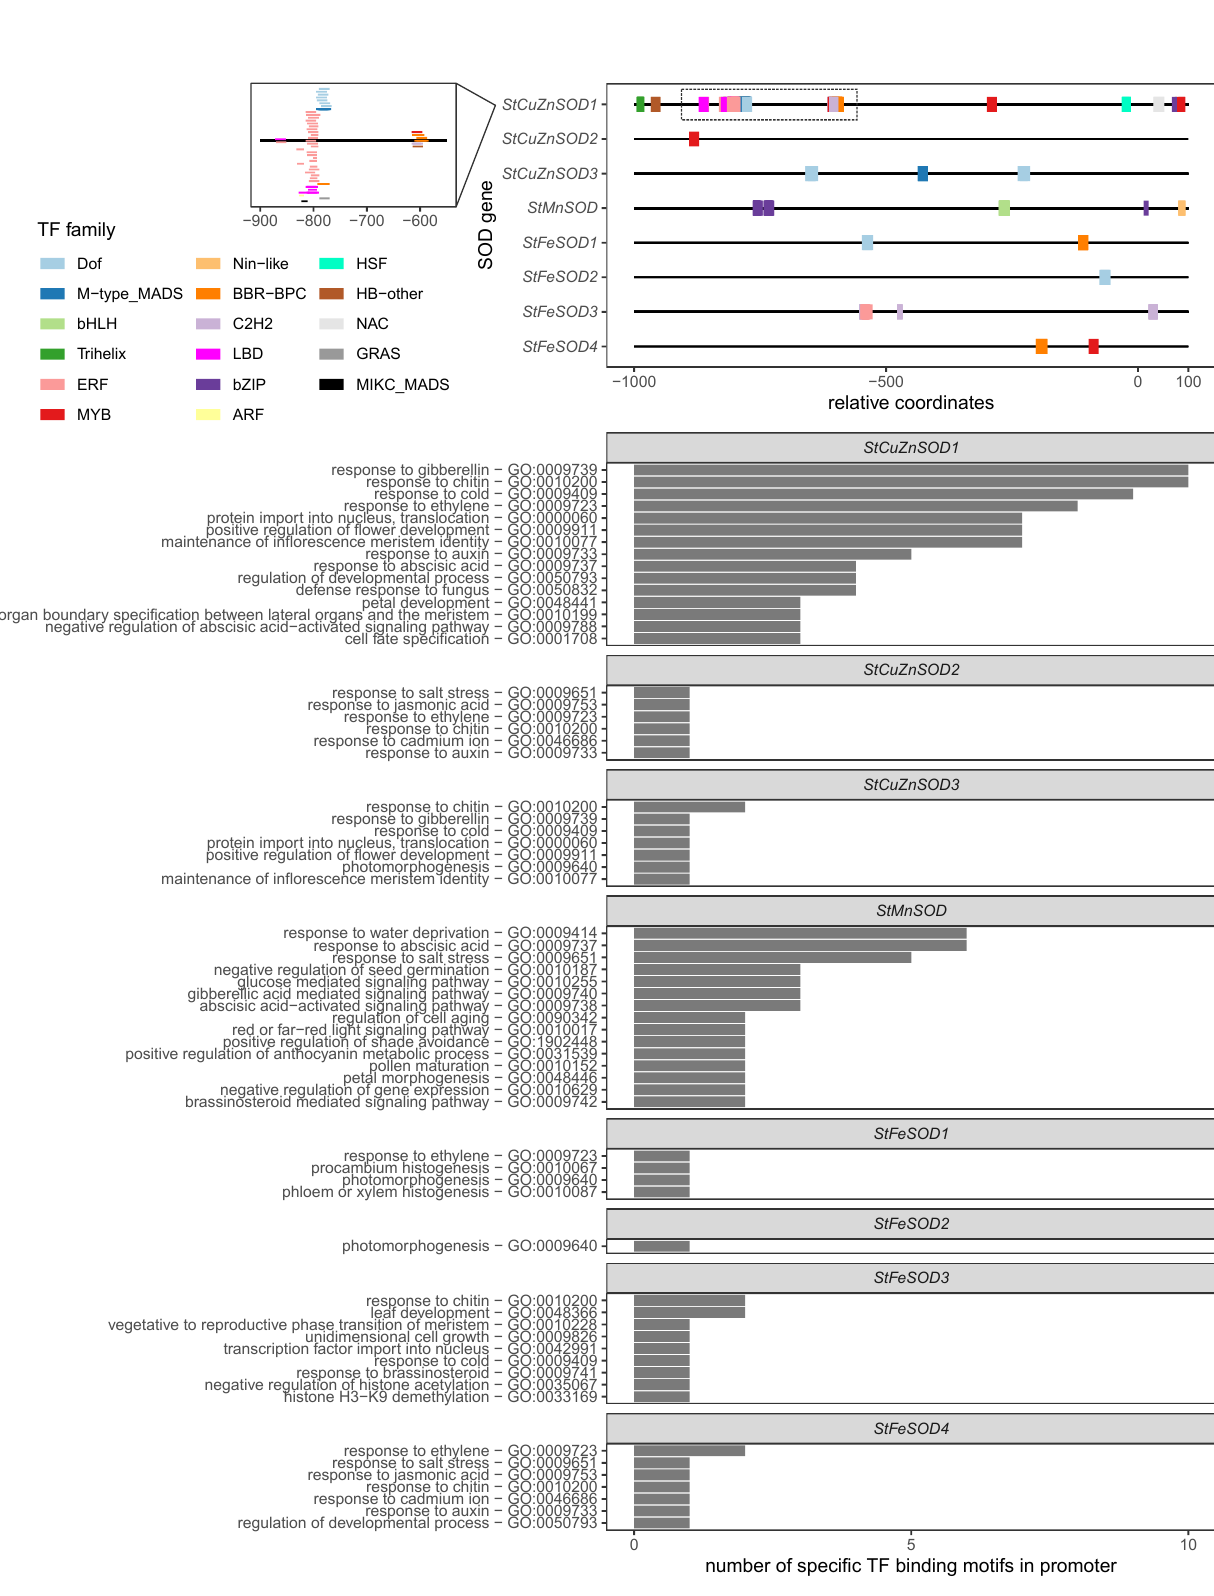
Figure 2. Transcription factor binding motifs in promoters of StSOD genes. ( A ) Location of binding sites for various TF families (color legend). ( B ) Biological process gene ontology terms associated with specific potato TFs which bind the identified motifs. Only unique GO terms per binding motif were counted. Non-informative terms (such as “process regulation of transcription, DNA-templated” and similar) present in all or most TF families were